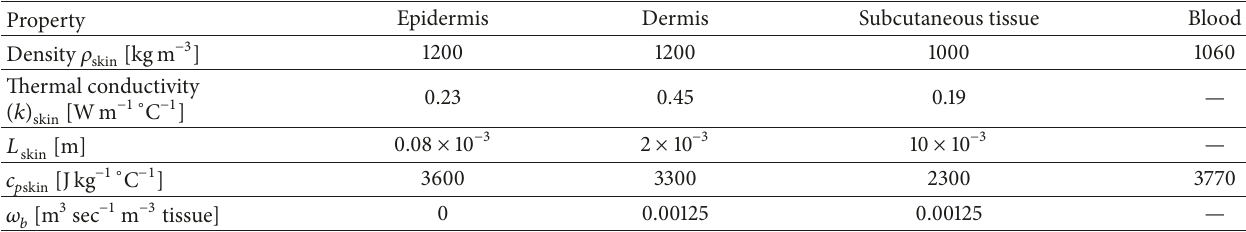
Table 2: Thermophysical and geometrical properties assigned to skin layers [14, 15,